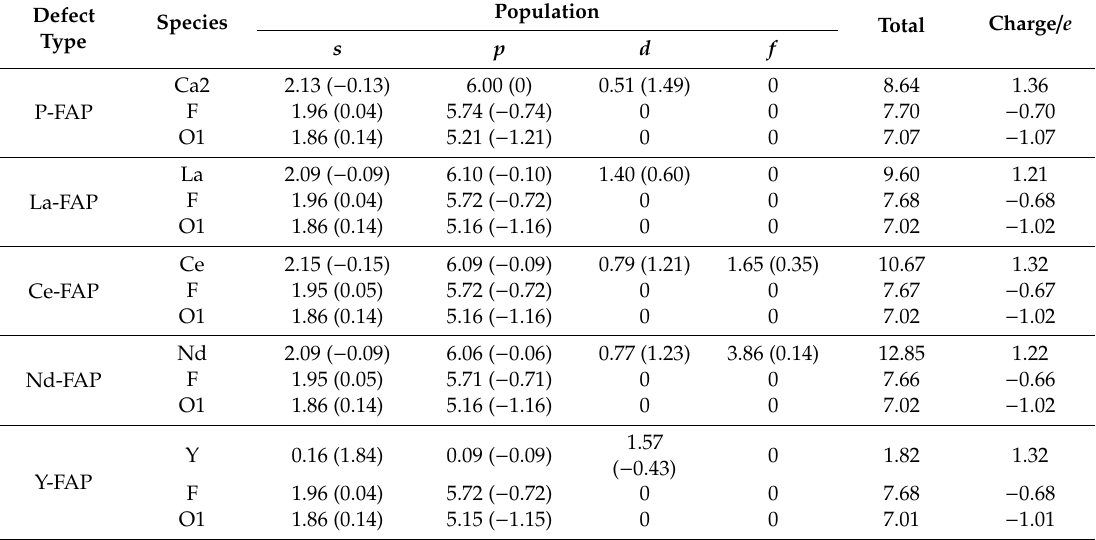
Table 2. Mulliken population of REE atom and the atoms adjacent to REE atom in REE-FAP crystals. Defect Type